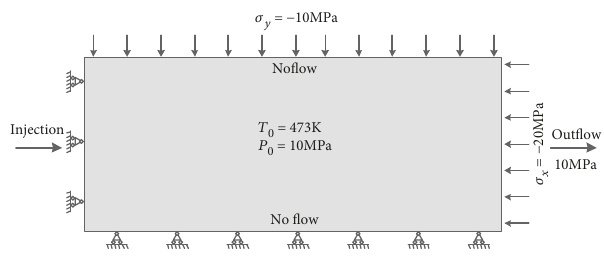
Figure 8: 2D numerical model and boundary